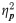
Vector tracks during left and right curve driving.Vector tracks from the 4 sites of activity plotted every 3 seconds during left and right curve driving, beginning 30 seconds from the start of the easement curve. (a) Vector tracks from the right PM (premotor cortex, channel 23) and the right FEF (frontal eye field, channel 18). In both areas, the left curve vector tracks are mainly in Phase 4, and the right curve vector tracks are in Phase -1. Significant differences between left and right curves are indicated by solid color dots. Significant differences were detected from 9.1 to 27.0 s in the right PM, and from 9.1 to 18.0 s in the right FEF (right PM: F [2, 144] = 4.210–7.266, p = 0.001–0.017, ηp2 = 0.06–0.1; right FEF: F [2, 144] = 3.636–4.265, p = 0.016–0.029, ηp2 = 0.05–0.06). (b) Vector tracts from the right PFC (prefrontal cortex, channels 1, 6, 12 and 17 [average]) and the left PFC (channels 4 and 16 [average]). Left curve vector tracks from the right PFC are in Phases 3 and 4, and right curve vector tracks are in Phase -1. Left curve vector tracks from the left PFC are in Phase 3, and right curve vector tracks are in Phase 1. Significant differences between left and right curves are indicated by solid color dots. Significant differences were detected from 0.0 to 30.0 s in the right PFC, and from 0.0 to 3.0 s and 9.1 to 30.0 s in the left PFC (right PFC: F [2, 585] = 3.786–18.77, p = 0.000–0.023, ηp2 = 0.01–0.06; left PFC: F [2, 291] = 3.318–6.585, p = 0.002–0.038, ηp2 = 0.022–0.043).